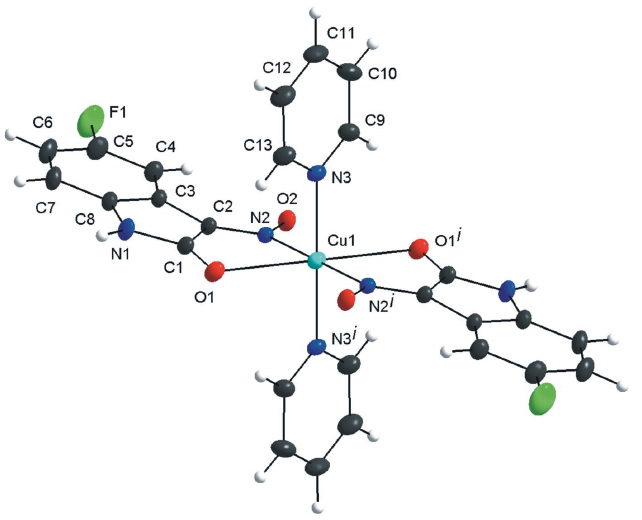
Figure 1 The molecular structure of the title compound, showing the atom labelling and displacement ellipsoids drawn at the 40% probability level. [Symmetry code: (i) (cid:5) x + 3 , (cid:5) y + 3 , (cid:5) z + 2 2